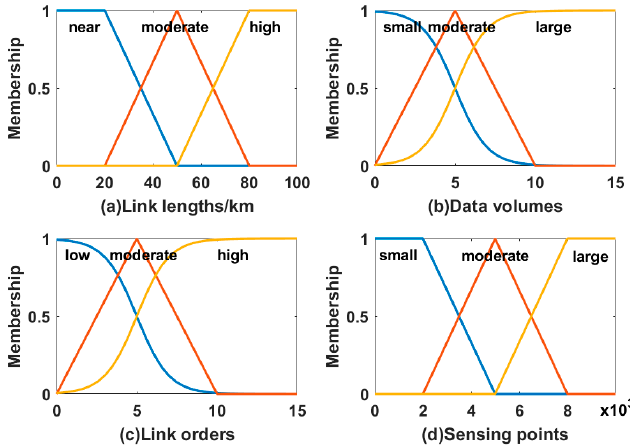
Figure 2. The fuzzy input sets mapping.